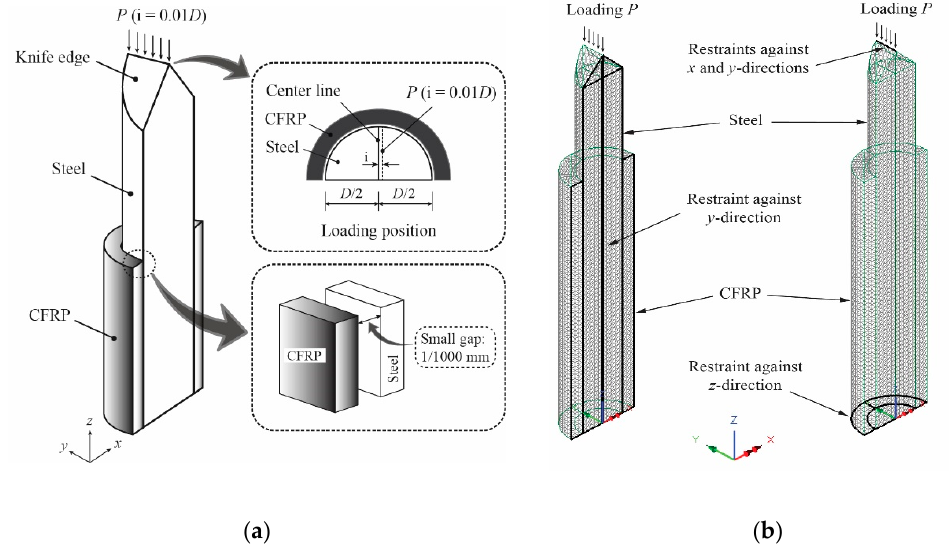
Figure 1. Features of the finite element (FE) model along with the boundary conditions and loading of steel members strengthened with unbonded carbon fiber-reinforced polymers (CFRP): ( a ) Summary of analytical condition; ( b ) Meshing